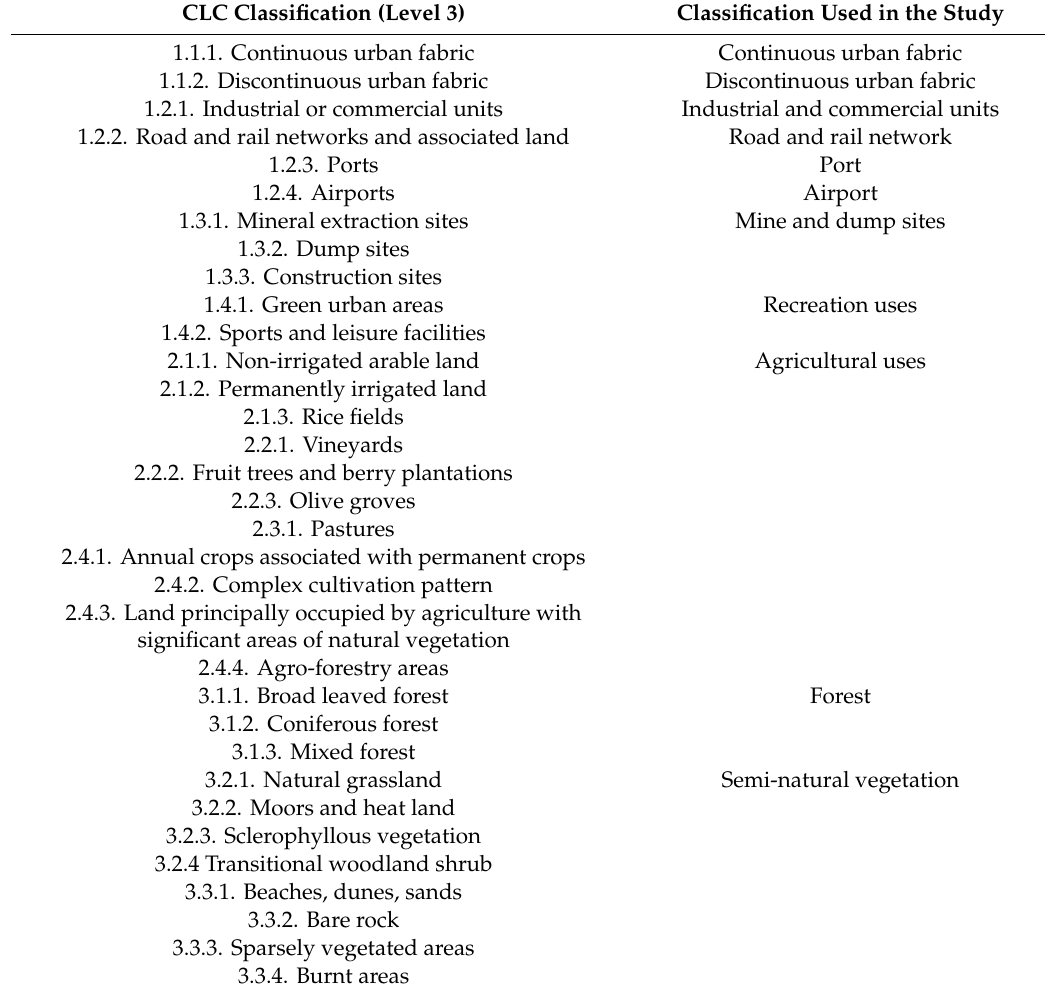
Table A1. Corine Land Cover classification used in the study.